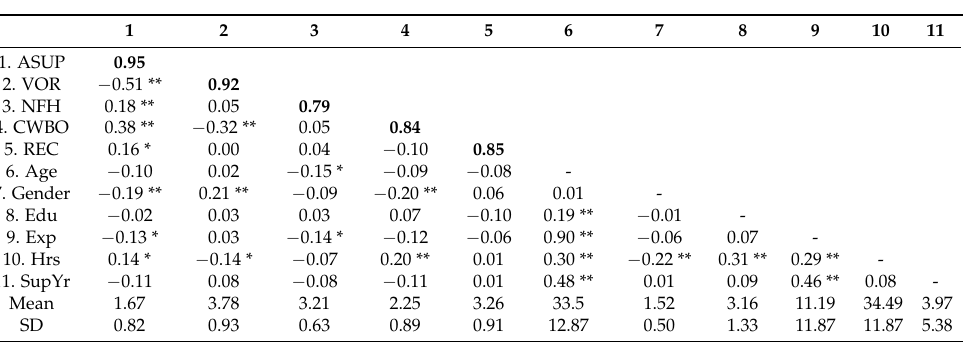
Table 2. Study 1 Correlation Matrix and Reliability.